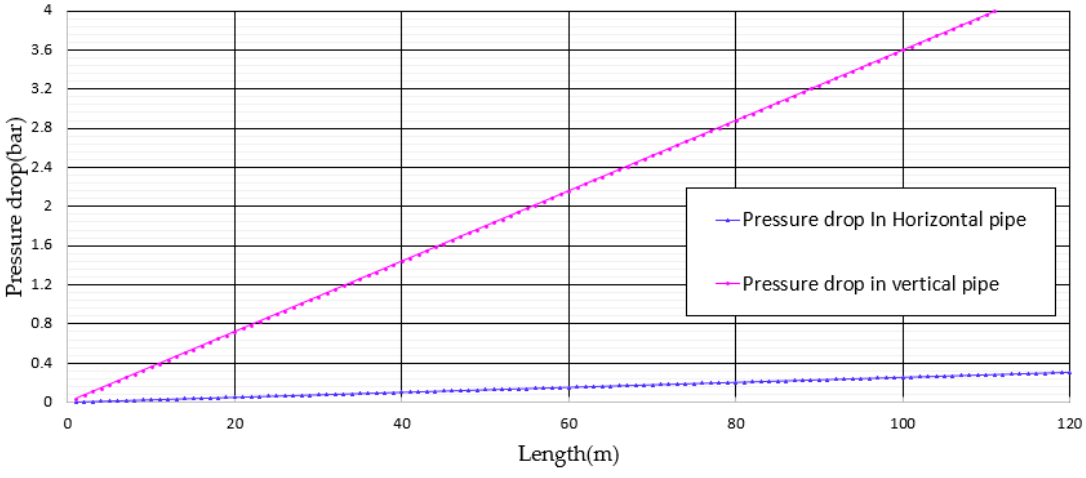
Figure 10. Pressure drop comparison between horizontal and vertical pipes.